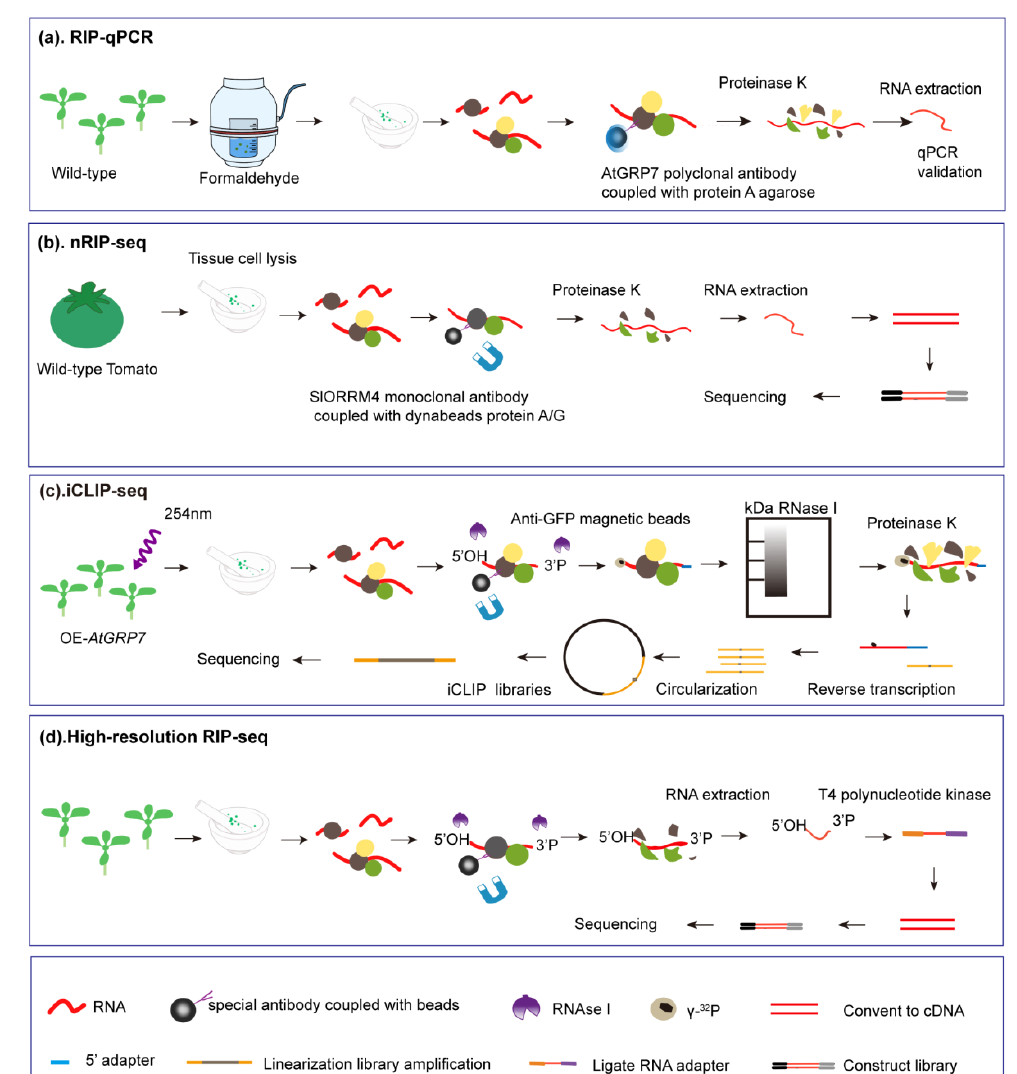
Figure 2. Workflow of RIP-qPCR, native RIP-seq, iCLIP and high-resolution RIP-seq analyses of plants. ( a ) RIP with a AtGRP7-specific antibody followed by qPCR to identify the binding status of AtGRP7 at the FLC locus. Point mutation of R 49 Q (Arg to Gln at the 49th amino acid) in the RRM motif was used as a negative control. Arabidopsis seedling tissue was cross-linked by 0.5% ( v / v ) formaldehyde. After tissue lysis, immunoprecipitation was performed using anti-AtGRP7 antibodies coupled with protein A agarose. Then, the protein was degraded by proteinase K, and RNA was extracted by acidic phenol/chloroform. The percentage of RIP-enriched RNA relative to that of input sample was determined by qRT-PCR. ( b ) For native RIP, tomato fruit (36 days post-anthesis (DPA)) cells were directly lysed and immunoprecipitation was performed using anti-SlORRM4 antibodies coupled with dynabeads protein A/G and proteins were digested using proteinase K. RNA extraction was performed and analyzed by next-generation sequencing. The negative control was IP from slorrm4 mutant with anti-SlORRM4. ( c ) The GFP-tagged AtGRP7 was expressed in the grp7 mutant. Plant materials used for iCLIP were subjected to crosslinking with UV light 254 nm wavelength. After sample homogenization in liquid N 2 , a lysate was prepared and RNA – protein complexes were precipitated using specific antibodies coupled with magnetic beads. RNAs were fragmented by treatment with RNAse I and the fragments were radioactively labeled at the 5′ end only. After proteins were digested and RNAs were isolated, iCLIP sequencing libraries were prepared. In parallel, the negative control libraries were immunoprecipitated for GFP-only transgene plants and AtGRP7 R4 9 Q-GFP plants. ( d ) For high-resolution RIP-seq, tissues extracts were pre-treated with RNAse I. Immunoprecipitation was then performed using a specific antibody that recognized the protein of interest. After the proteins were digested, the RNA was phosphorylated using a T4 polynucleotide kinase and processed for sequencing using a Small RNA-seq Kit.